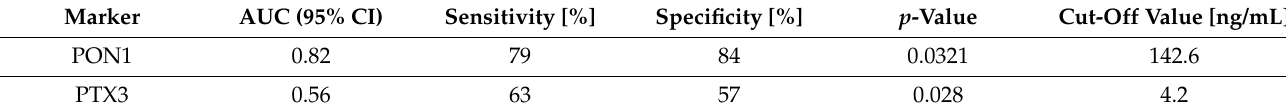
Table 6. The diagnostic values of PON1 and PTX3 for patients with endometrial cancer.